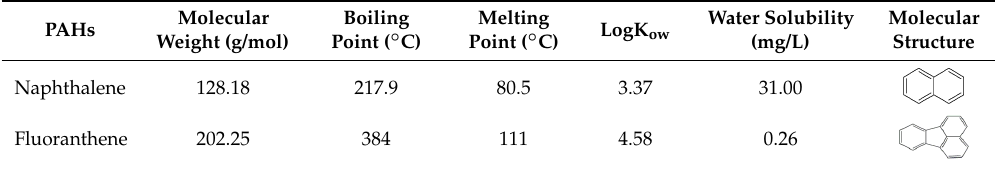
Table 1. Physicochemical properties of polycyclic aromatic hydrocarbons (PAHs).